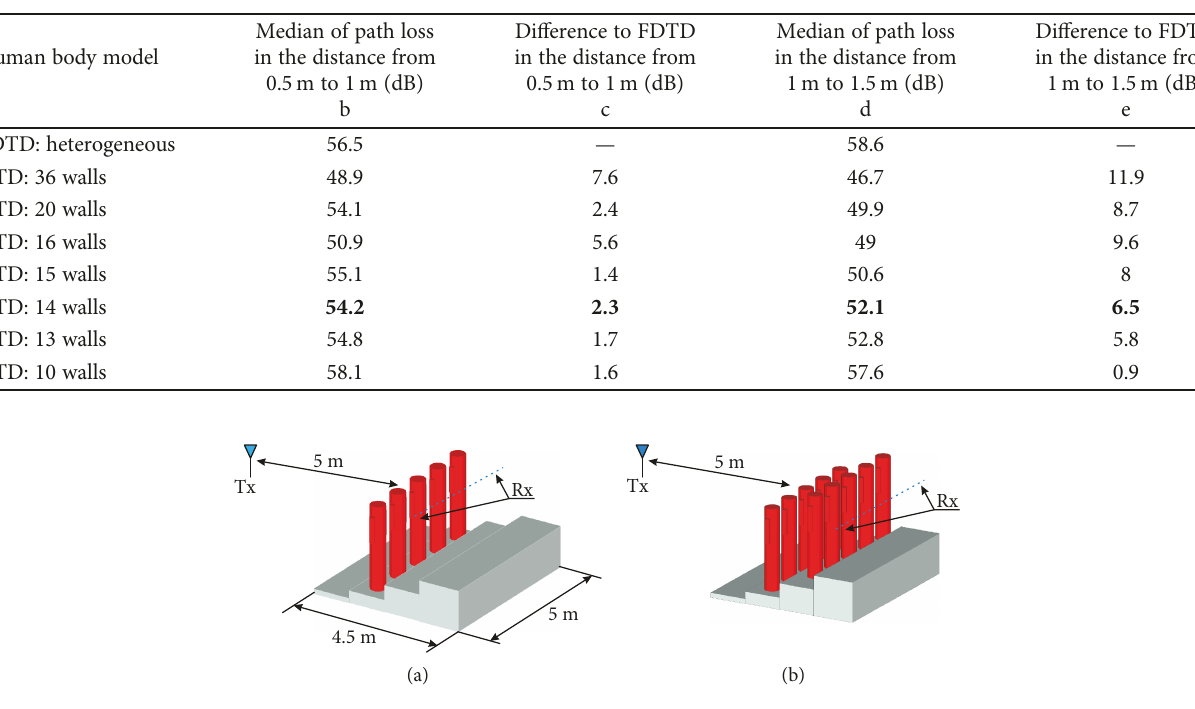
Figure 13: The simulation scenarios of the 5G system: (a) 5 people in one row; (b) 10 people in 2 rows.